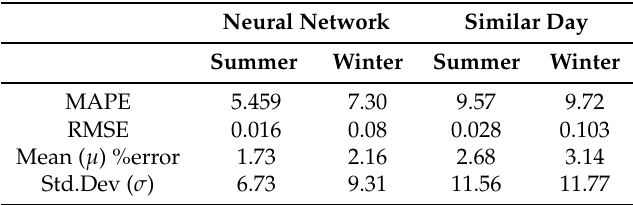
Table 4. Errors from thermal demand